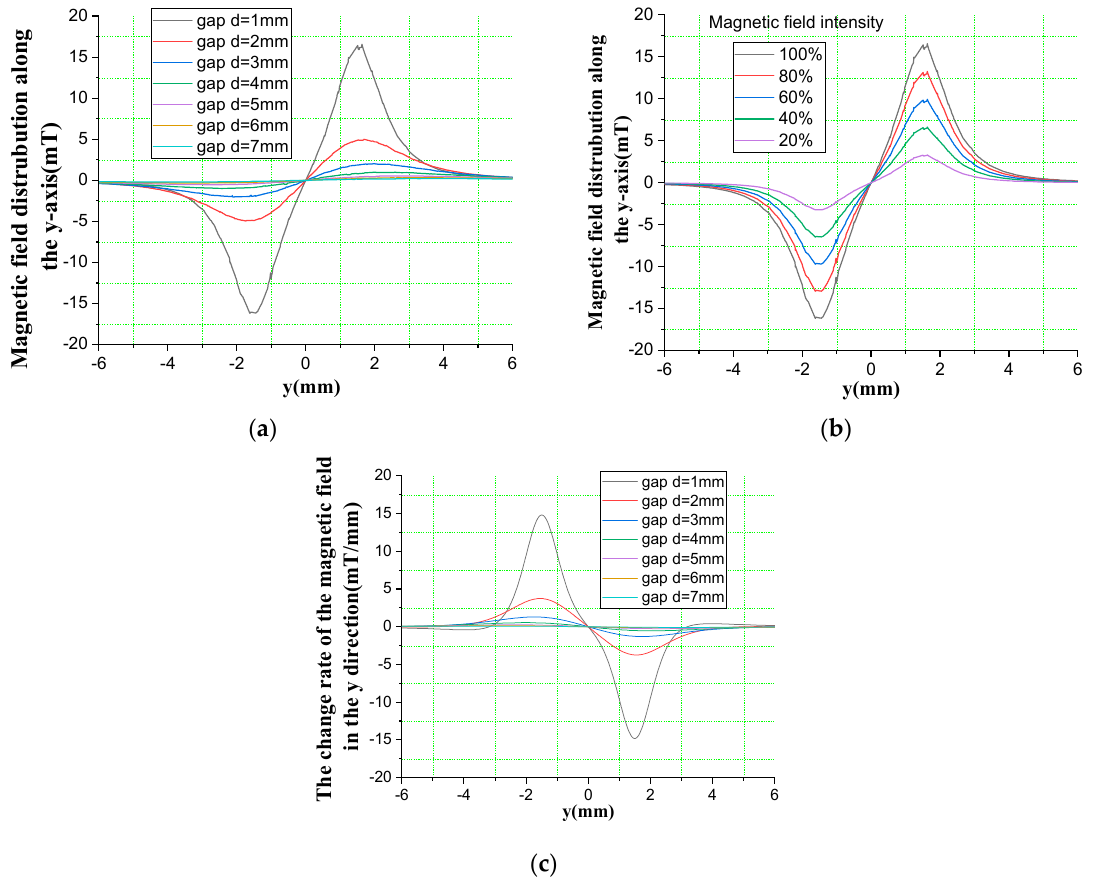
Figure 6. Magnetic field characteristic in different conditions ( a ) Magnetic field distribution along the y-axis in the tunnel magnetoresistive sensor versus different gaps; ( b ) Magnetic field distribution along the y-axis in the tunnel magnetoresistive sensor versus different magnetic field intensity of permanent magnetic film (d = 1 mm); ( c ) The change rate of the magnetic field in the y direction due to a displacement variation in the z direction versus different gaps.